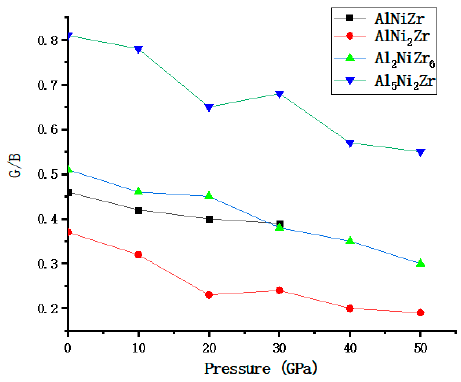
Figure 3. The dependence relations of G / B values with pressures for Al x Ni y Zr z compounds.